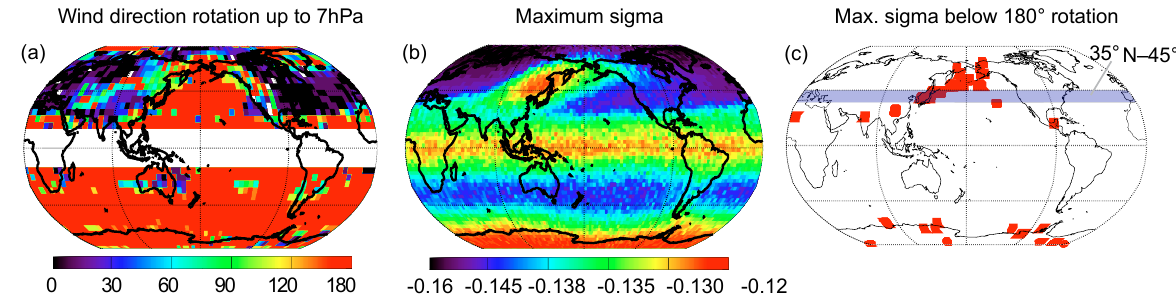
Figure 5. Vertical rotation of the wind direction between the surface and 7hPa (a) , distribution of maximum σ 2 values (b) , and grid points where the maximum σ 2 values were detected below the critical rotation level (c) . All the results are for the DJF season. The color scale represents the rotation in degrees (a) and σ 2 (b) .